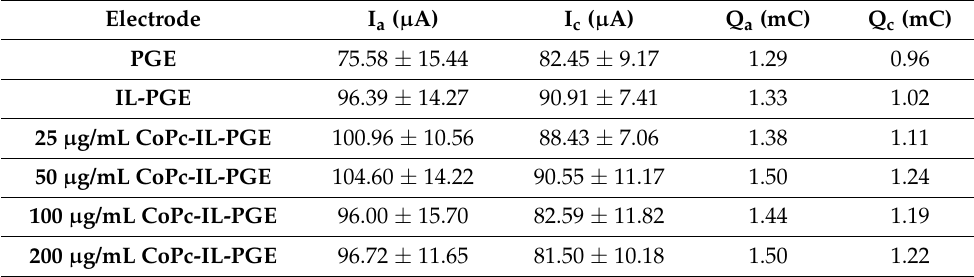
Table 1. The average values (n = 3) of anodic peak current (I a ), the cathodic current (I c ), the anodic charge (Q a ), and the cathodic charge (Q c ) obtained by using PGEs, IL-PGEs, and CoPc-IL modified PGEs in various concentration of